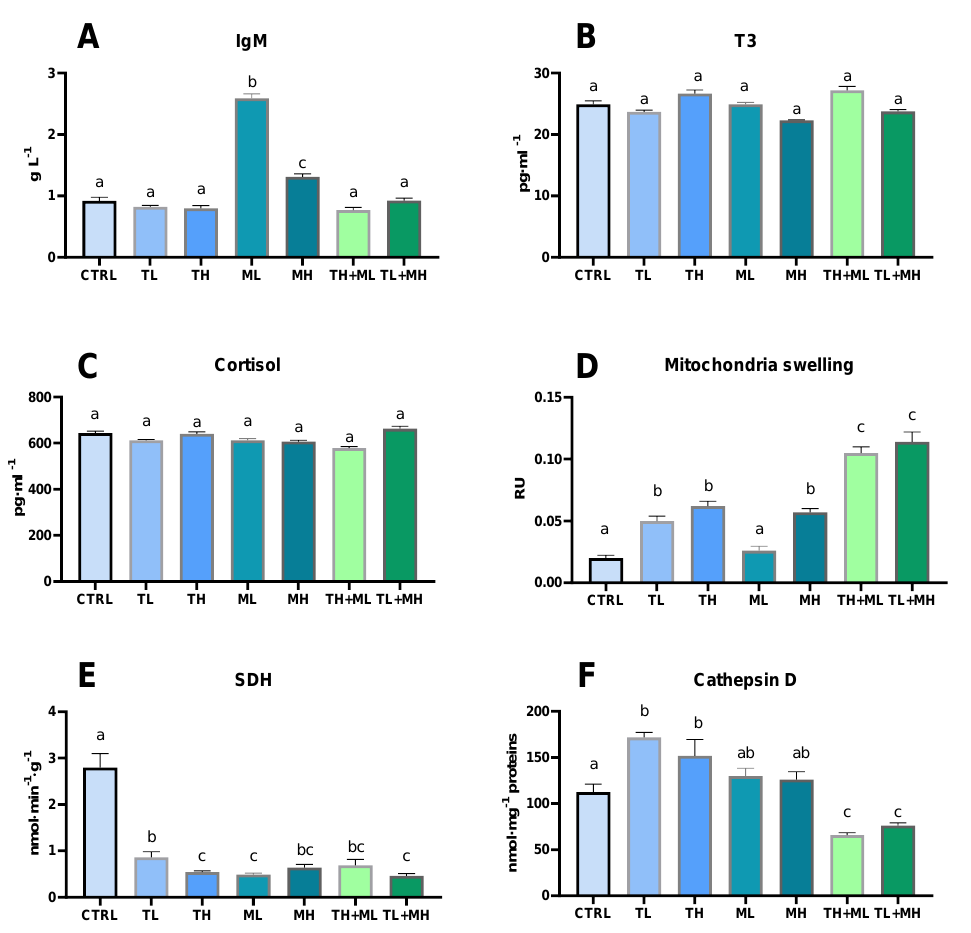
strand breaks level (Figure 4A). Only the TL + MH mixture led to a slight decrease in DNA fragmentation.